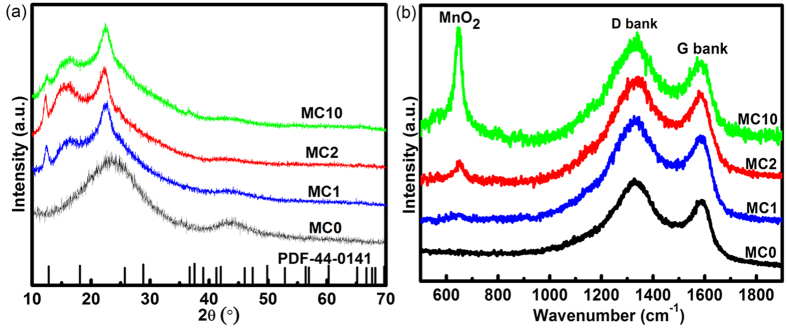
(a) XRD and (b) Raman spectra of MC samples.